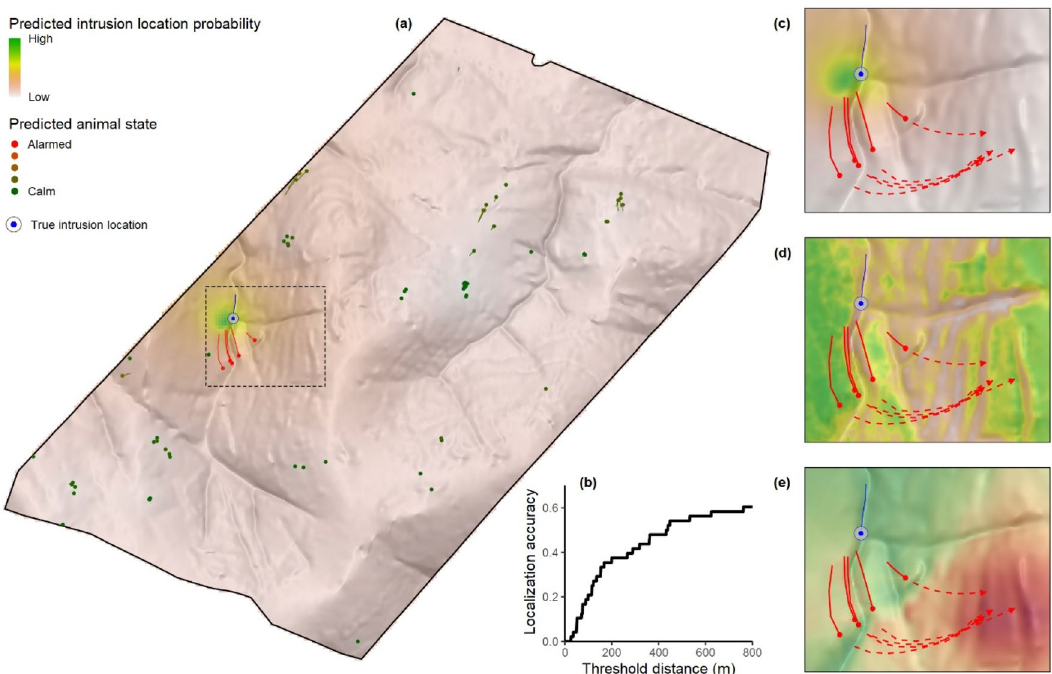
Figure 3. Spatial performance of our early warning system. ( a ) The predicted spatial probability surface for the intrusion’s location (based on data from the sentinel animals only) for one of the experimental intrusions. For all experiments where the intrusion was algorithmically detected (82.5%), the spatial localization accuracy as function of threshold distance ( b ) that 54.2% of these correctly detected intrusions could be localized with a spatial error of less than 500 m and 20.8% within 100 m. The dashed focal area shown in ( a ) is highlighted in ( c – e ), where the sentinels’ (here: wildebeest) movements in the next 10 min is indicated with dashed lines. ( c ) The spatial localization prediction of the intrusion. The evasive movements of the fleeing wildebeest are fast compared to their normal movement at that location (Fig. 1b), and highly aligned. While fleeing, the wildebeest move through habitat with a low suitability ( d , see Fig. 1c), and towards areas that are energetically costly to reach ( e , movement costs are computed based on topography and relative to their current position, where the cost of movement is assumed to be inversely proportional to movement speed on an incline as computed using Tobler’s hiking function). The experimental intrusion as depicted in this figure is animated in Supplementary Movie 1, including output from the animal classification and intrusion localization algorithms. All maps were generated in R3.5.0 using GIS, location and modelled data 49 .